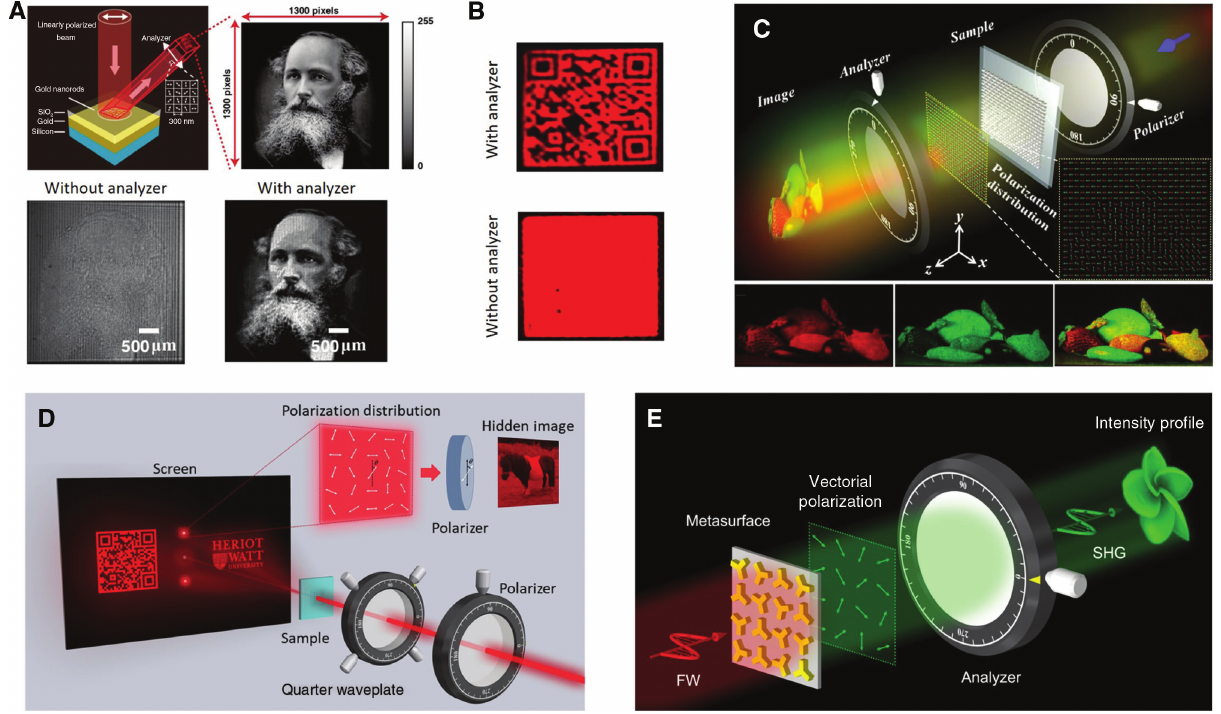
Figure 3: Optical metasurfaces for engineered polarization profiles. (A) Schematic for hiding a high-resolution grayscale image. Under the illumination of linearly polarized light, a grayscale image is hidden in the polarization profile of a reflected beam from the metasurface and revealed by a linear polarizer (analyser) [111]. (B) Generation of quick response (QR) code for anticounterfeiting [112]. (C) Top: schematic for the polarization encoded color image. Bottom: experimental results for incident light with red, green and two colors [113]. (D) Schematic of the multichannel metadevice for anticounterfeiting and encryption [115]. (E) Schematic of nonlinear vectorial metasurface for optical encryption [116]. Reprint permission obtained from [111–113, 115,